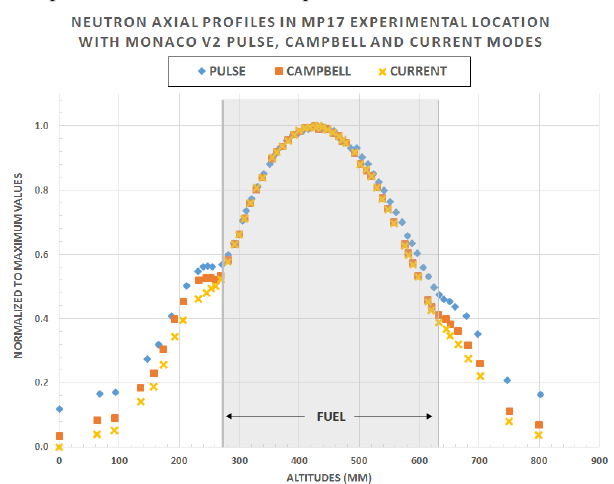
Figure 4: Normalized axial neutron flux profiles in pulse, Campbell and current modes using MONACO v2 system and FC2288. Normalized values are describing the same neutron profile shape, validating the three modes when operated in their predestined neutron flux range. Current mode has a mixed sensitivity to neutron and gamma. Neutron/gamma contribution ratios are strongly changing at both fuel interfaces, explaining the quasi absence of signal bump in that region in current mode.